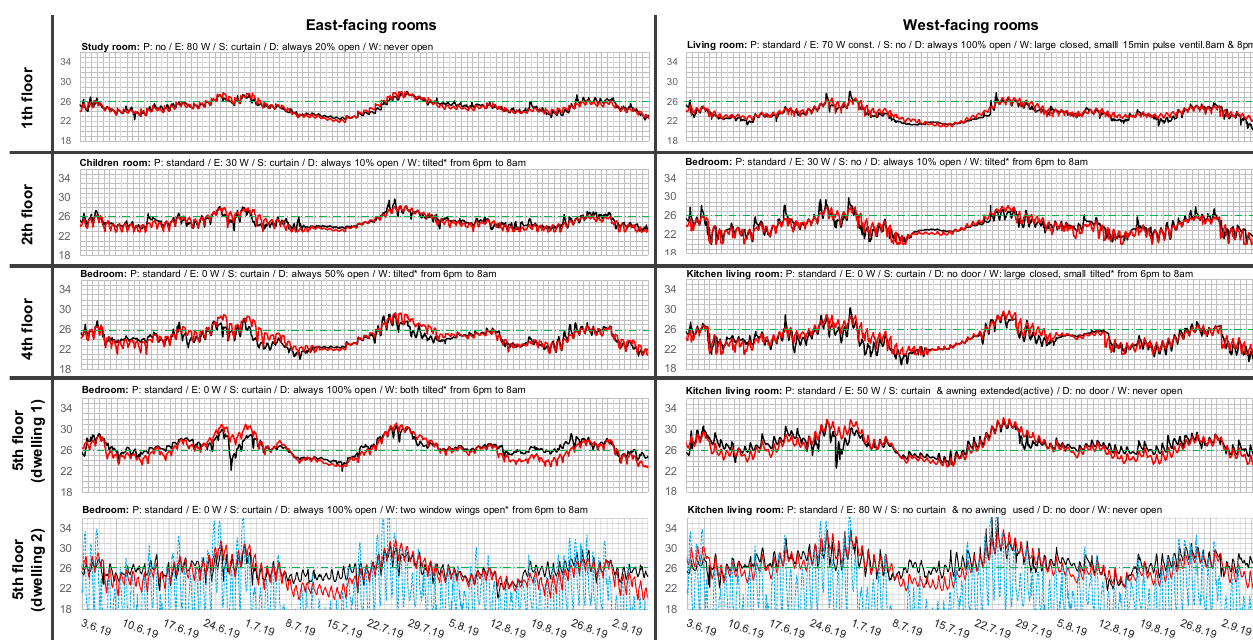
Figure 6. Measured (black curve) and simulated (red curve) room temperature profiles (in °C) for all rooms monitored in the GZH dwellings (including the presence of residents) from 3 June until 7 September 2019. The simulation parameters for the individual rooms of the final simulation variant are written above each diagram (P…per- sons/occupant profile (standard means profile according to room use illustrated in Figure A1), E…equipment load, S…sun protection (“curtain” with an F c = 0.7), D…room door opening, W…window opening profile (* window open if room temperature is >22 °C and outdoor temperature < room temperature).